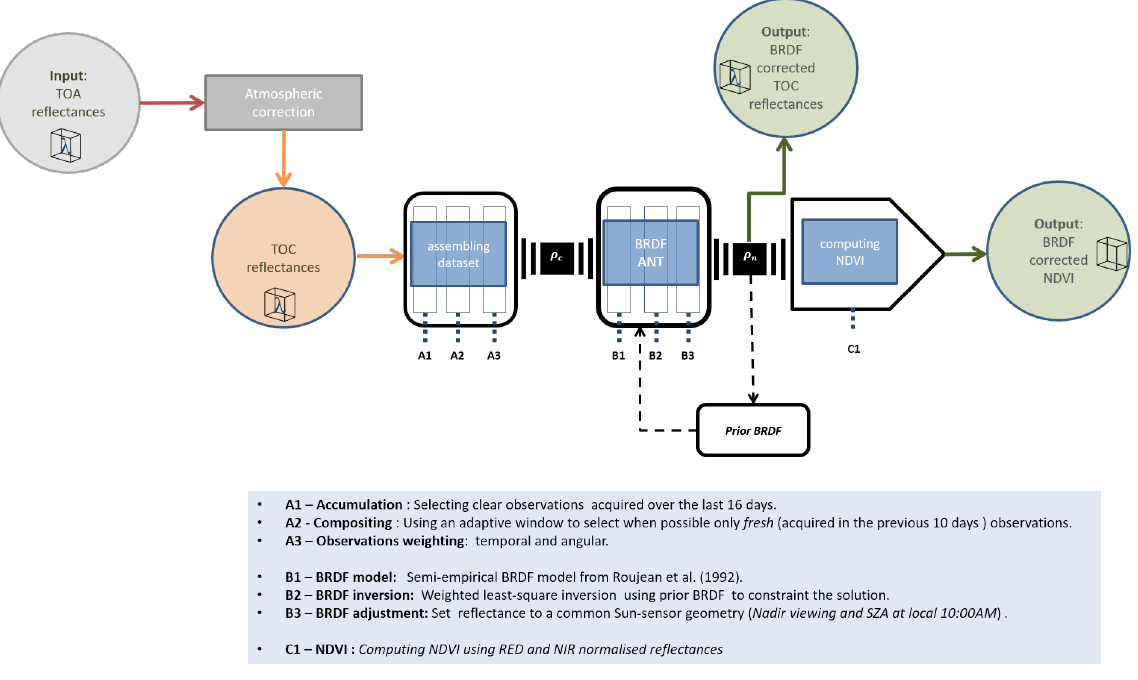
Figure 2. Diagram flow of the BRDF processor. Inputs and outputs are TOC reflectances and NDVI, respectively. The BRDF correction is applied independently to each spectral band and is